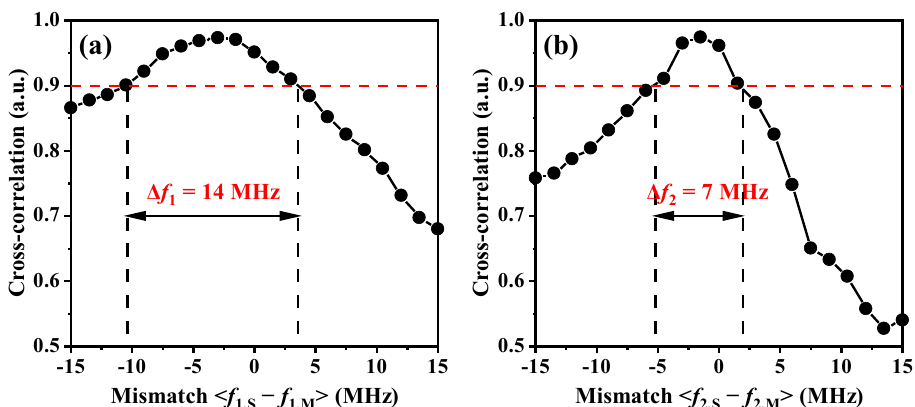
Figure 8. Influence of PM driving signal in the phase sections mismatch on chaotic synchronization coefficients: ( a ) the frequency ( f 1 = 10 GHz) in the Phase 1 section and ( b ) the frequency ( f 2 = 10 GHz) in the Phase 2 section.